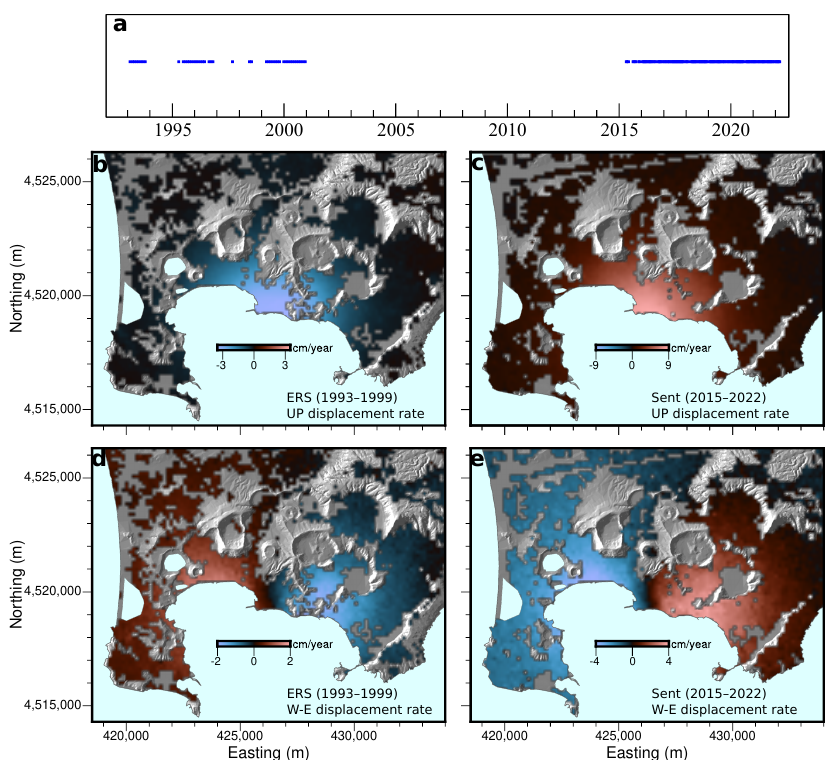
Figure 4. Time series of SAR vertical and horizontal displacements. ( a ) Dates of vertical and hori- zontal displacement data used in this work. ( b ) Mean upward displacement rate during 1993–1999, ERS/ENVISAT. ( c ) Mean upward displacement rate during 2015–2022, Sentinel-1A. ( d ) Mean east- ward displacement rate during 1993–1999, ERS/ENVISAT. ( e ) Mean eastward displacement rate during 2015–2022,